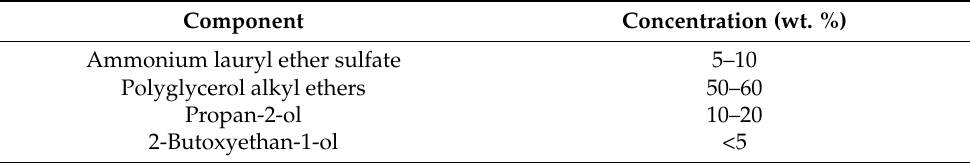
Table 2. Surfactant composition